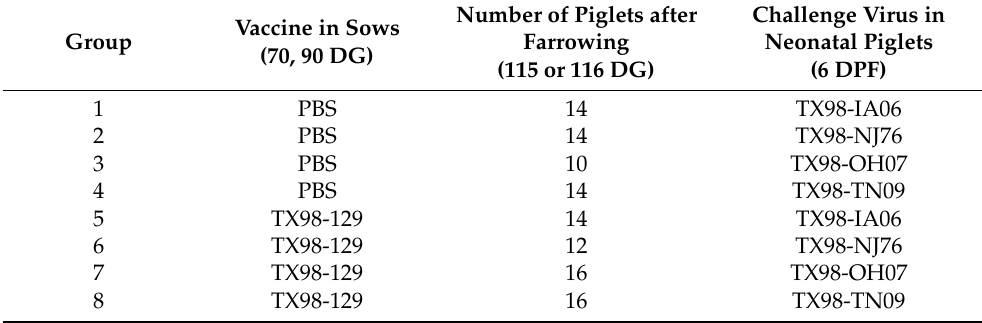
Table 2. Design of pig experiment to evaluate vaccine-induced passive immunity in neonatal piglets. Challenge Virus in Number of Piglets after Vaccine in Sows Neonatal Piglets Farrowing Group (70, 90 DG) (6 DPF) (115 or 116 DG) PBS 14 TX98-IA06 PBS 14 TX98-NJ76